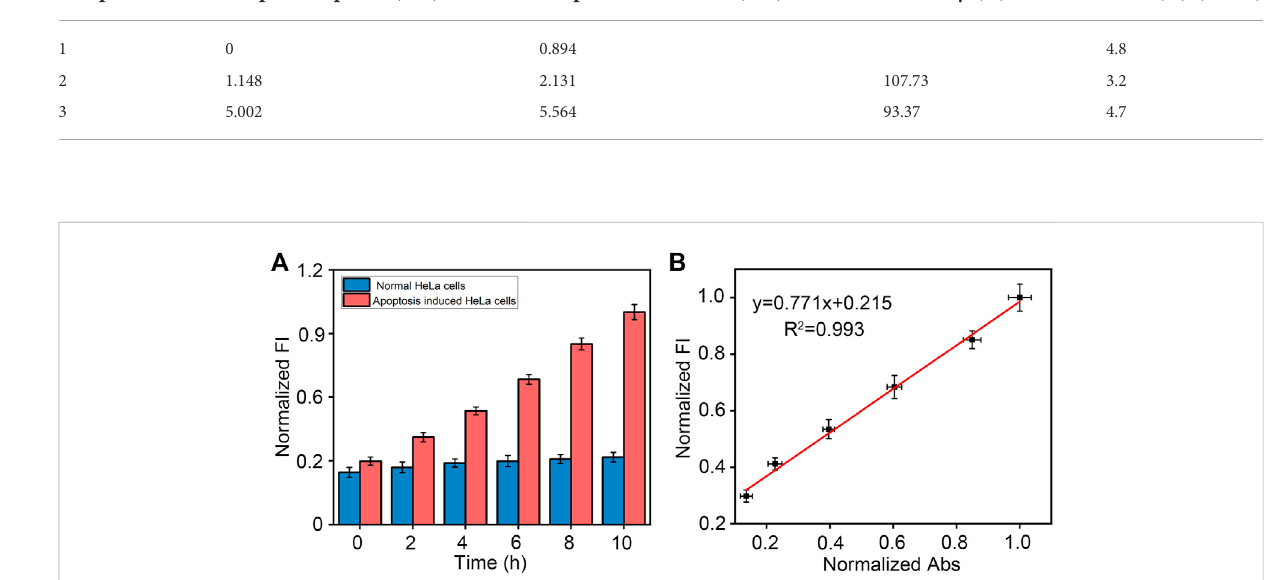
TABLE 1 Determination of Caspase-3 in the Cell Extract Sample Using Our Designed bio-nanomicelles. Sample